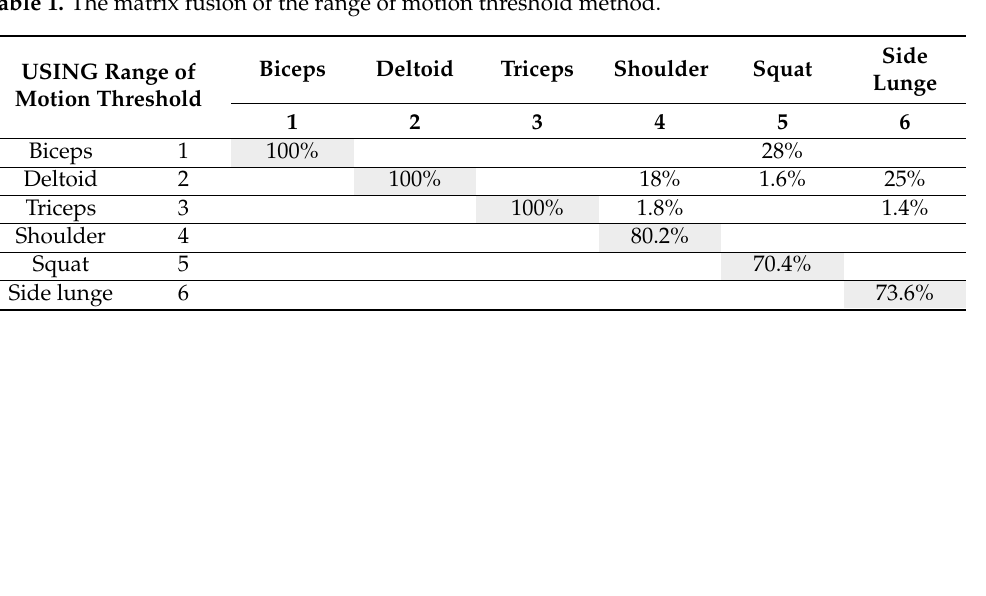
Figure 10. Human interface machine with dumbbell exercise.